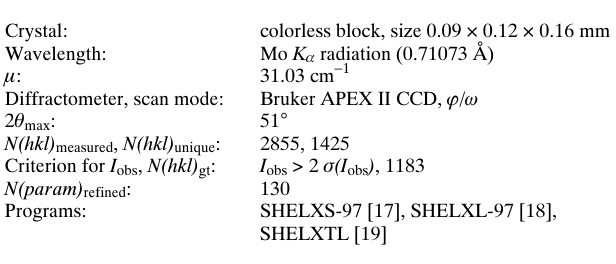
Table 1. Data collection and